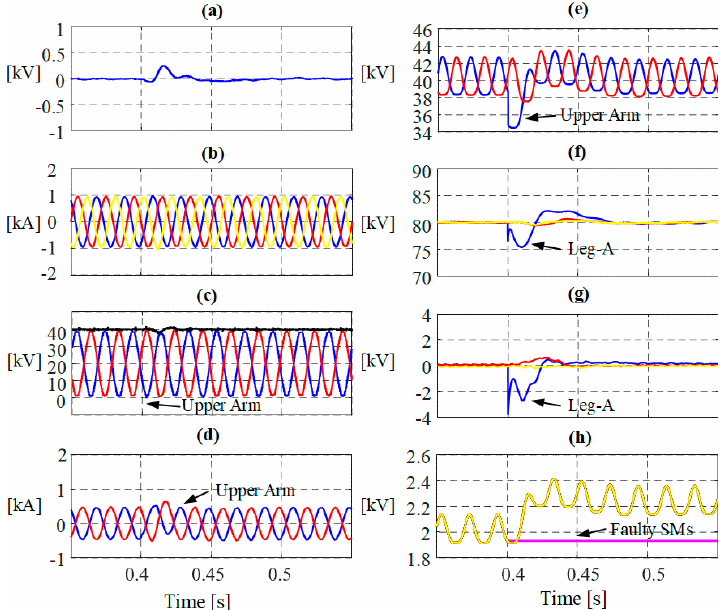
Figure 10. Simulation waveforms of the MMC under SM fault and control scheme-A operates in reactive power mode: ( a ) dc current, ( b ) ac current, ( c ) leg A upper and lower arm voltages superimposed on its common-mode voltage, ( d ) leg A upper and lower arm currents, ( e ) leg A upper and lower capacitor voltage sums, ( f ) common-mode capacitor voltage sums of three phase-legs, ( g ) differential-mode capacitor voltage sums of three phase-legs, and ( h ) leg A upper arm SM voltages.